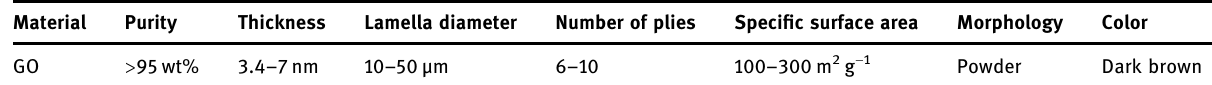
Table 2: Parameters of GO